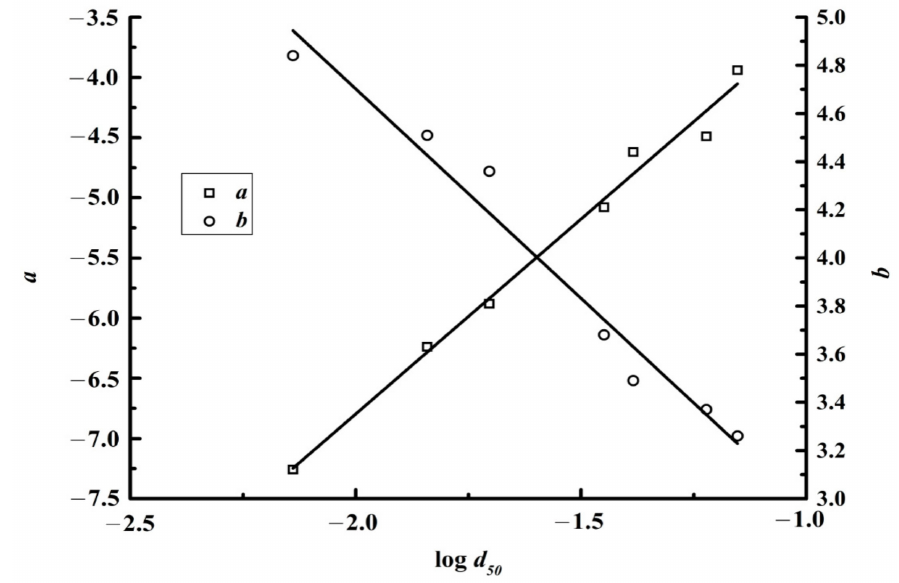
Figure 5. Relationship of parameters a , b and d 50 . Both a and b appear to vary linearly with d 50